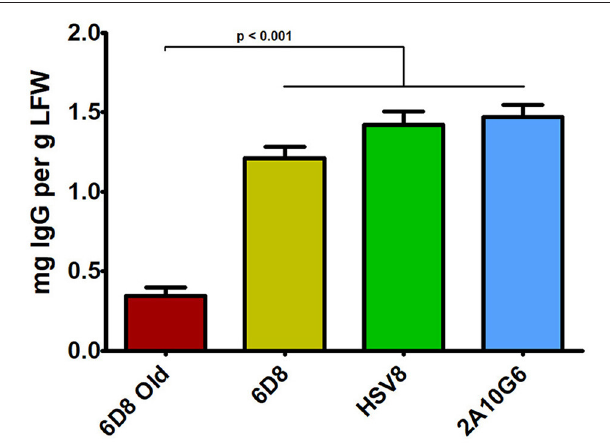
FIGURE 5 | IgG production of three mAbs using optimized plant-expression vectors. Leaves of N. benthamiana agroinfiltrated with unoptimized (6D8 old) or optimized (6D8, HSV8, c2A10G6) BeYDV vectors were harvested at 5 DPI and protein extracts were analyzed for IgG production by ELISA using human IgG as a reference standard. Columns represent results from three independently infiltrated leaf samples ± standard error.